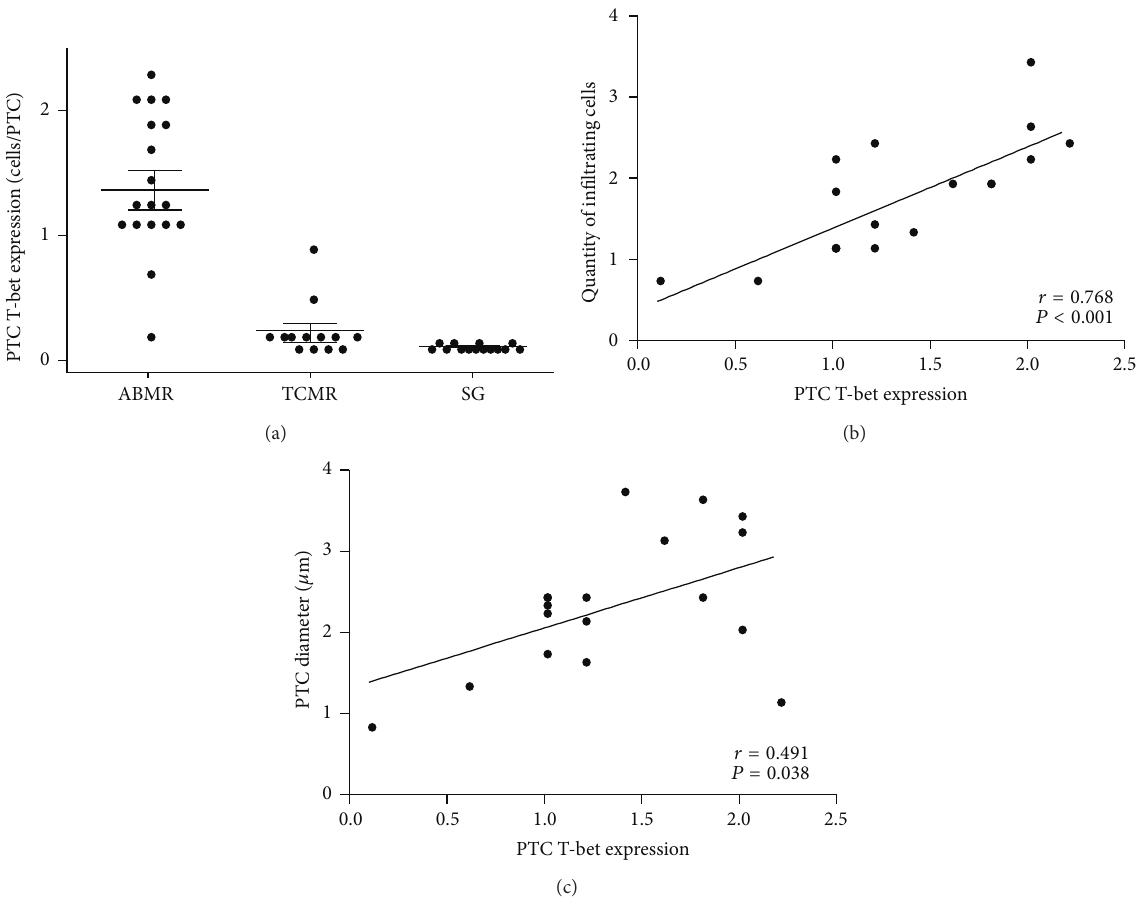
Figure 3: T-bet expression in antibody-mediated rejection (ABMR). (a) Quantitative measurement of the number of intra-PTC T-bet- expressing cells in the ABMR, T cell-mediated rejection (TCMR), and stable graft (SG) groups. In the ABMR group, T-bet expression was strongly correlated with the quantity of infiltrating cells (b) and peritubular capillary (PTC) diameter